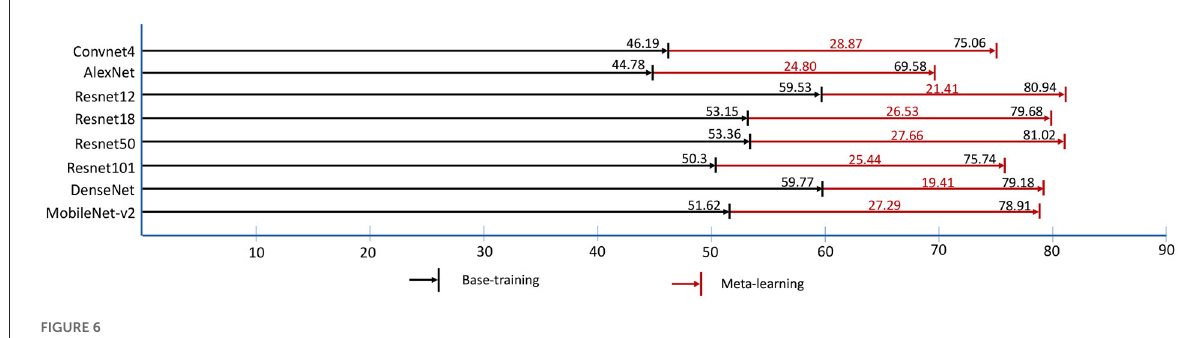
edges, lines, and colors, to textures and patterns, to